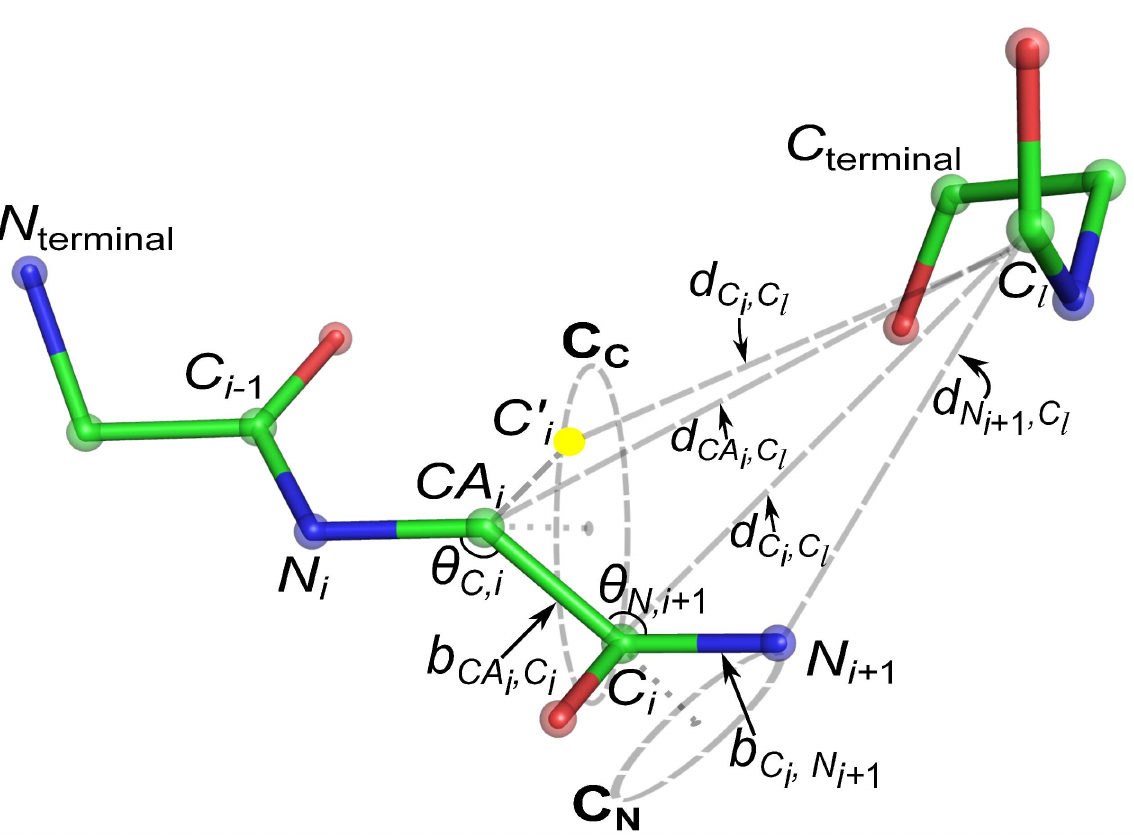
Figure 3. Schematic illustration of placing C i and N i z 1 atoms. Atom C i has to be on the circle C C . The position x C , i of the C i atom of residue i is determined by d C , which is based on known distance d CA i , C l be placed on two positions with equal probabilities. Here x C , i is the selected position of C i . C ’ i (yellow ball) is placed at the position x C ’ , i alternative to x C , i . Similarly, the N i z 1 atom has to be on the circle C N and its position x N , i z 1 is determined by d N